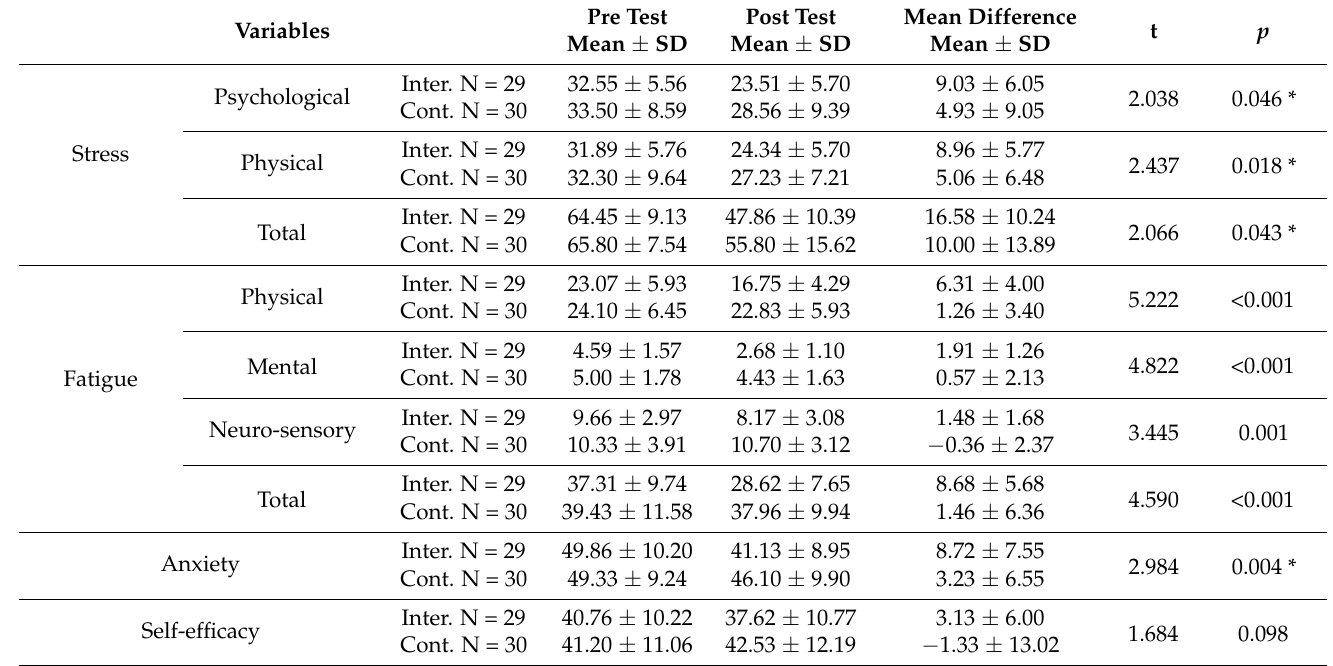
Table 3. Effects of Meridian